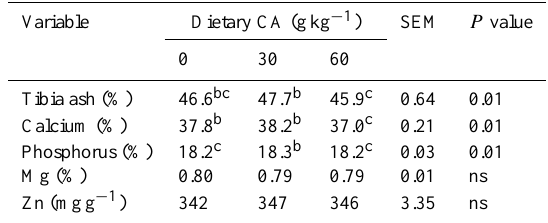
Table 7. Effect of citric acid on intestinal morphology of broiler chicks a .